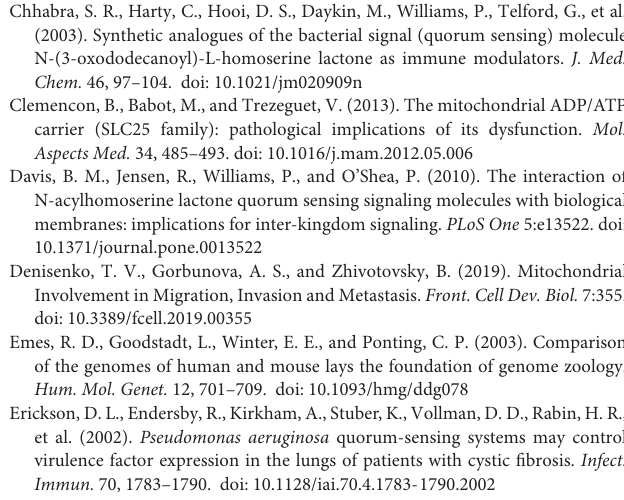
FIGURE S1 | Cell viability in 3O-C 12 -HSL-treated cells. Two cell types, (A) fibroblasts and (B) intestinal epithelial cells were either treated with 0.02% DMSO as a diluent (Control), or exposed to 3, 10, 50, or 100 µ M 3O-C 12 -HSL for 4, 24, 48, or 72 h, and then analyzed using AlamarBlue assay. Columns represent the mean ± SE. No significant differences are indicated by with “ns,” as analyzed by two-tailed Student’s t -test. Data are from at least six independent experiments done on separate days on different cell passages. TABLE S1 | Differentially expressed proteins in mitochondria enriched fraction of fibroblasts after treatment with 10 or 50 µ M 3O-C 12 -HSL for 4 h compared to the diluent control. TABLE S2 | Differentially expressed proteins in mitochondria enriched fraction of Caco-2 cells after treatment with 10 or 50 µ M 3O-C 12 -HSL for 4 h compared to the diluent control. TABLE S3 | Differentially expressed proteins in mitochondria enriched fraction of fibroblasts after treatment with 10 µ M 3O-C 12 -HSL for 4 h compared to the diluent control, Student’s t -test. TABLE S4 | Differentially expressed proteins in mitochondria enriched fraction of fibroblasts after treatment with 50 µ M 3O-C 12 -HSL for 4 h compared to the diluent control, Student’s t -test. TABLE S5 | Differentially expressed proteins in mitochondria enriched fraction of Caco-2 cells treated with 10 µ M C12-HSL for 4 h compared to the diluent control, Student’s t -test. TABLE S6 | Differentially expressed proteins in mitochondria enriched fraction of Caco-2 cells treated with 50 µ M C12-HSL for 4 h compared to the diluent control, Student’s t